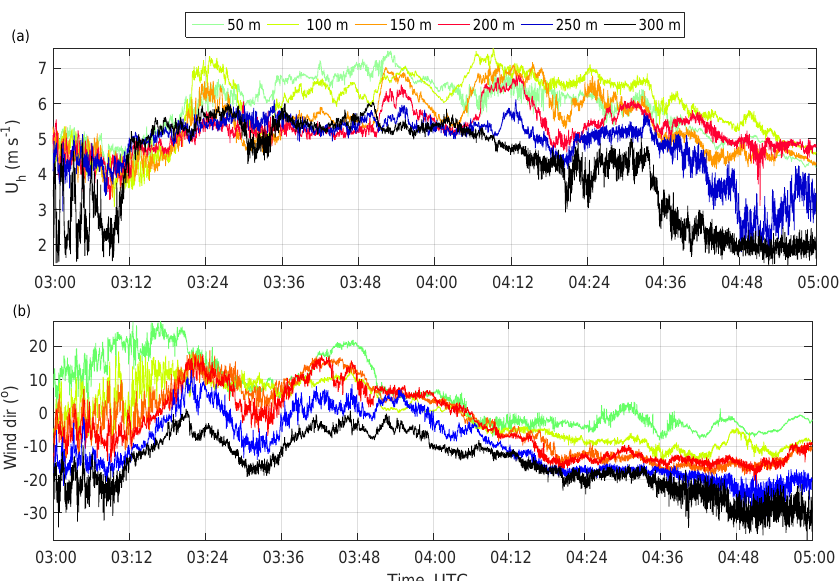
Figure 3. Wind velocity measurements obtained from the NW sonic anemometers installed on the met tower: (a) horizontal velocity; (b) wind direction. 21 April 2015, 03:00–05:00UTC.